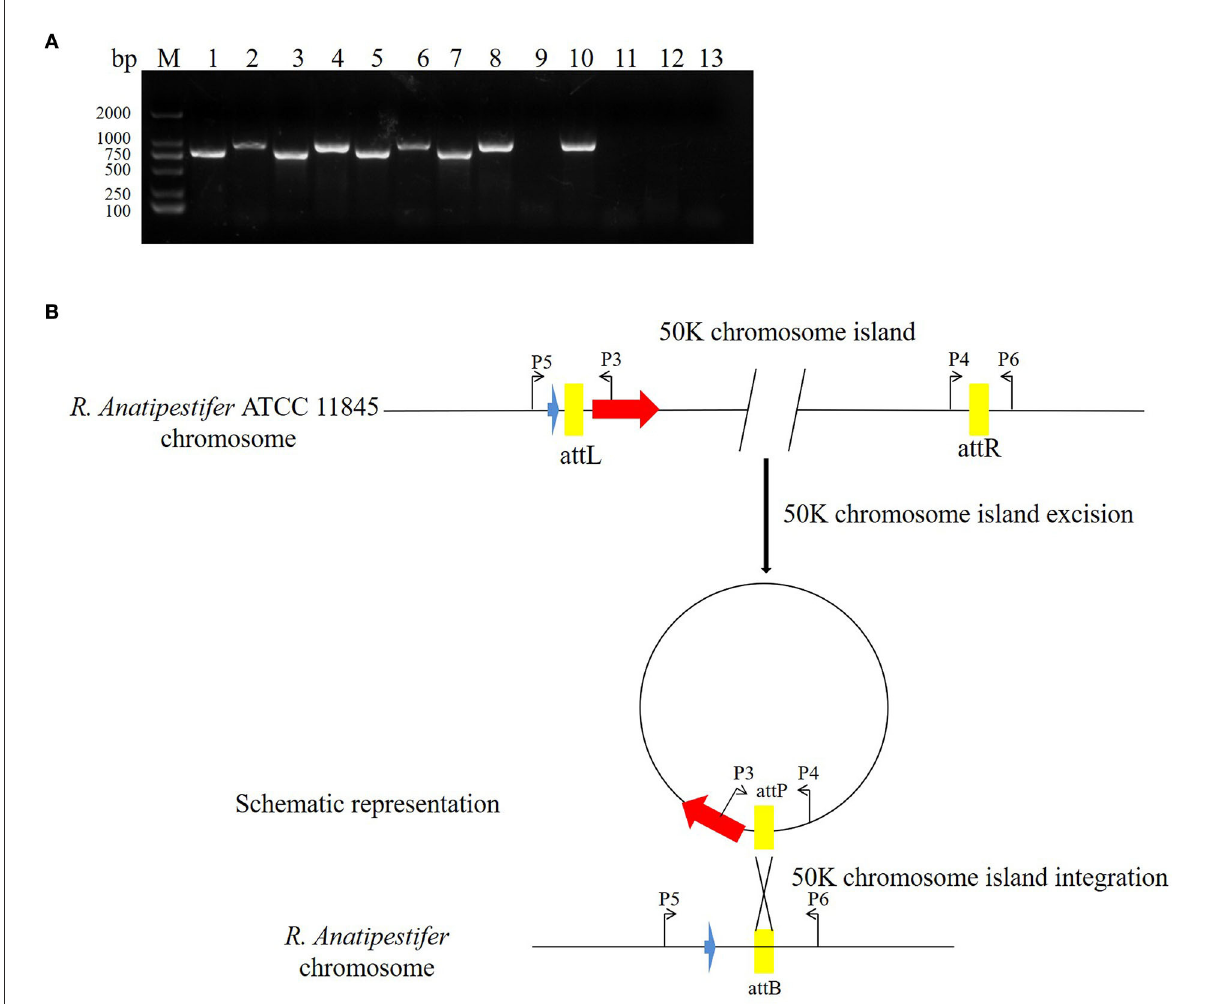
FIGURE5 The 50K genomic island integration and excision. (A) The primer pairs P3/P4, P5/P6 were used for detecting genomic island excision, and P3/P5, P4/P6 were used for detecting genomic island integration in R. anatipestifer ATCC 11845, RA-YM, and clinical isolated strain no. 1. M: DL2000 DNA marker; lane 1: DNA fragment was amplified with P3/P4 primer pair from R. anatipestifer ATCC11845; lane 2: DNA fragment was amplified with P5/P6 primer pair from R. anatipestifer ATCC11845; lane 3: DNA fragment was amplified with P4/P6 primer pair from R. anatipestifer ATCC11845; lane 4: DNA fragment was amplified with P3/P5 primer pair from R. anatipestifer ATCC11845; lanes 5–8: DNA fragment was amplified with same primer from R. anatipestifer YM; lanes 9–12: DNA fragment was amplified with same primer from R. anatipestifer clinical isolated strain no. 1; lane 13: negative control; R. anatipestifer ATCC 11845 and RA-YM genomic islands had the integration and excision function. (B) Schematic representation of the integration and excision